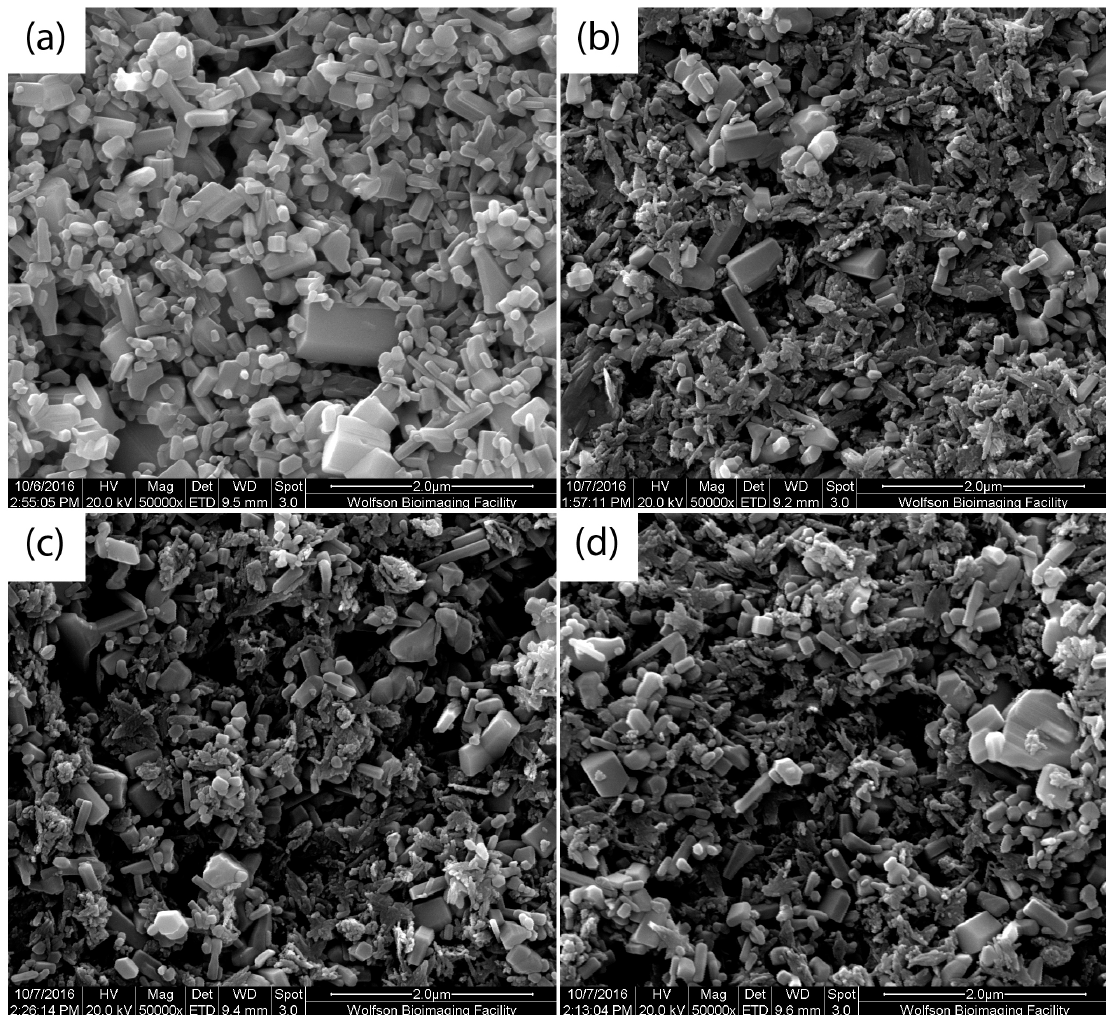
Figure 2. SEM images of nano-surfaces: ( a ) 1% pure ZnO ( b ) 1% ZnO and CuO suspensions with the ratio of 1:2 ( c ) 1:1 ( d )